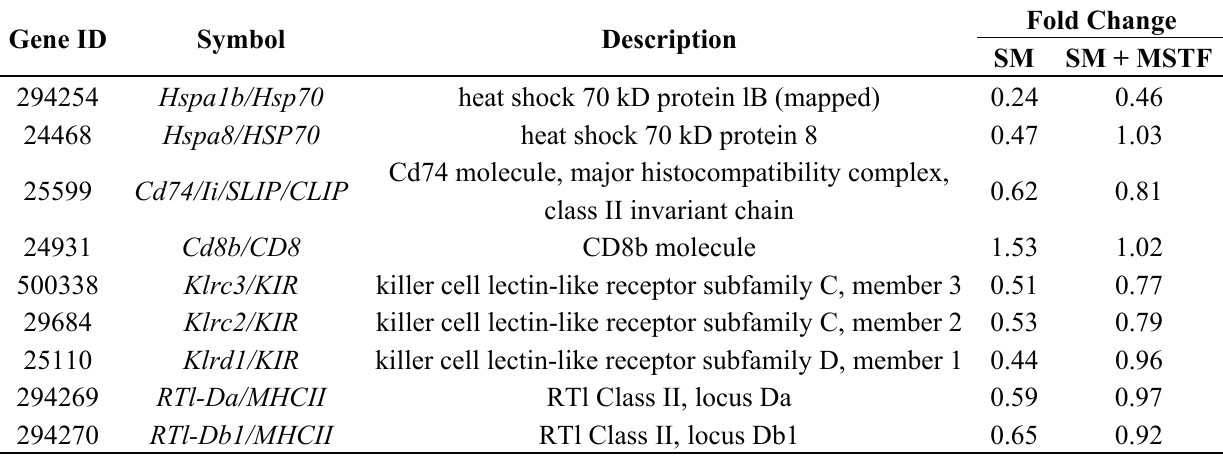
Table 6. List of 9 genes involved in antigen processing and presentation. These SM-induced alterations of expression were abolished or attenuated by MSTF